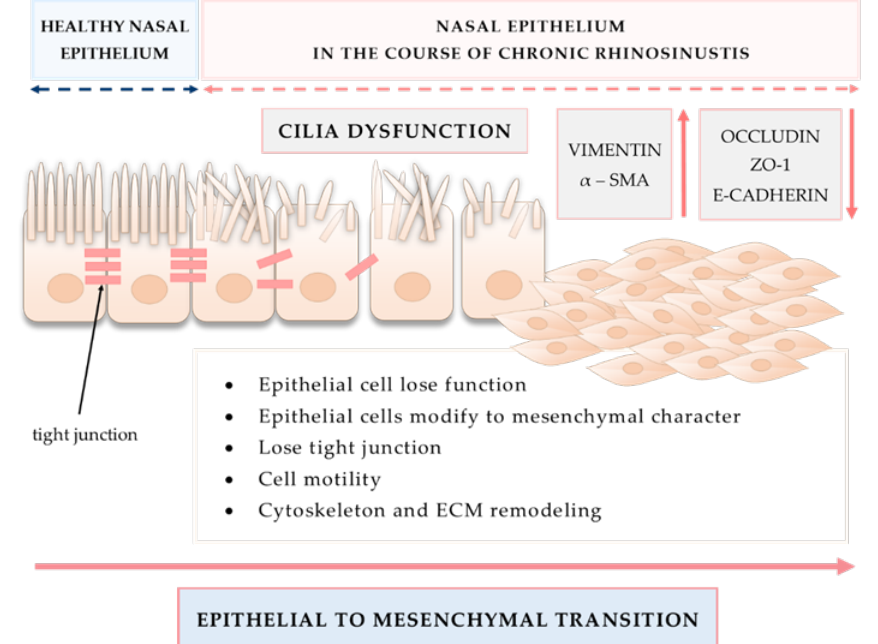
Figure 6. Epithelial to mesenchymal transition as an important mechanism involved in tissue re- modeling in CRS. remodeling in